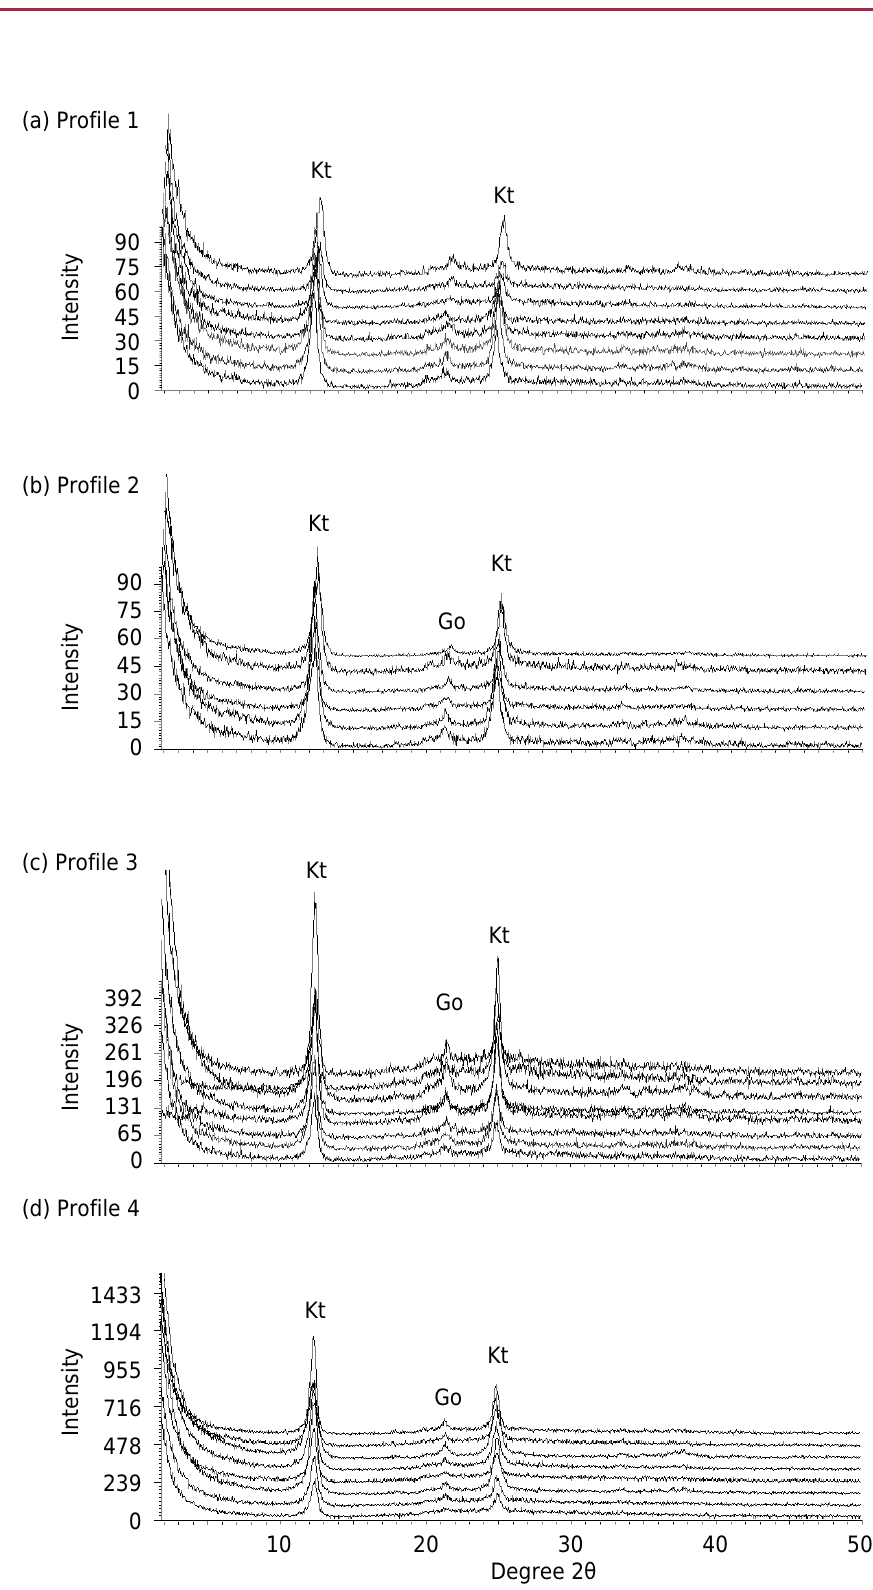
Figure 3. X-ray diffraction patterns of natural clay fraction in horizons from soil profiles located in the Rio de Janeiro State, Southeastern Brazil. Go: goethite; Kt: